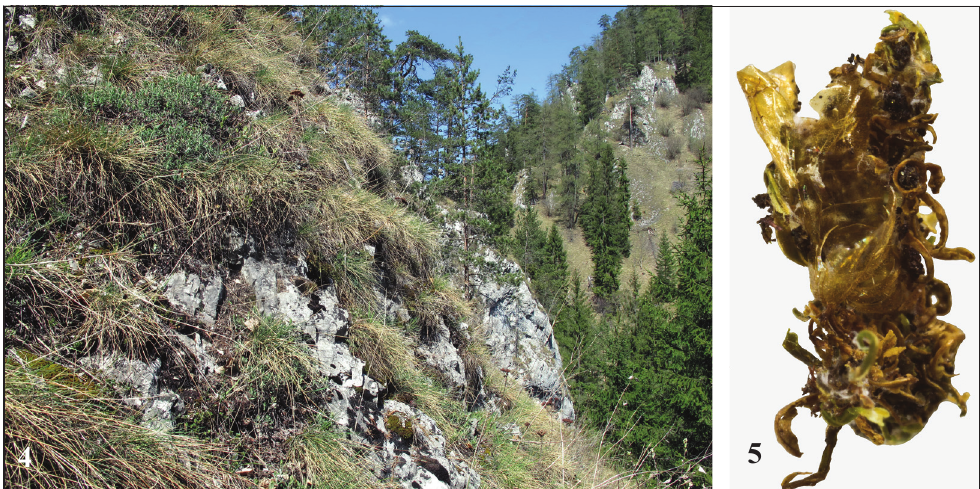
Figure 6. Map of distribution of Eulamprotes gemerensis in Slovakia.